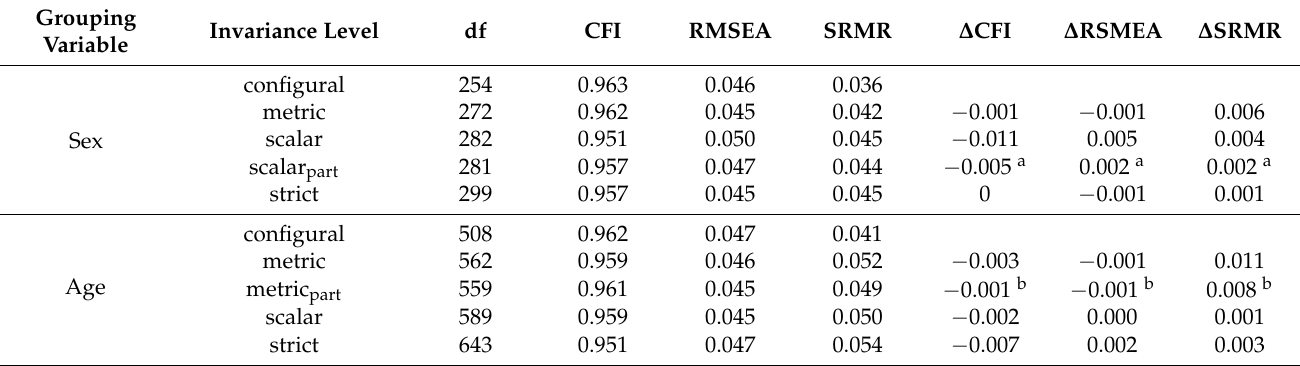
Table 2. Model fit estimates of the invariance